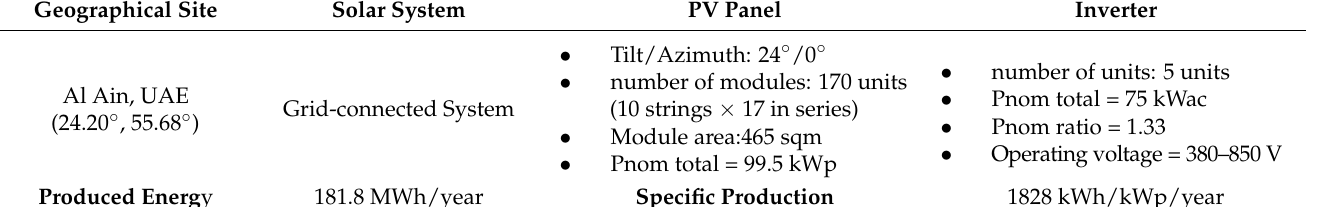
Table 2. Summary of solar energy system.